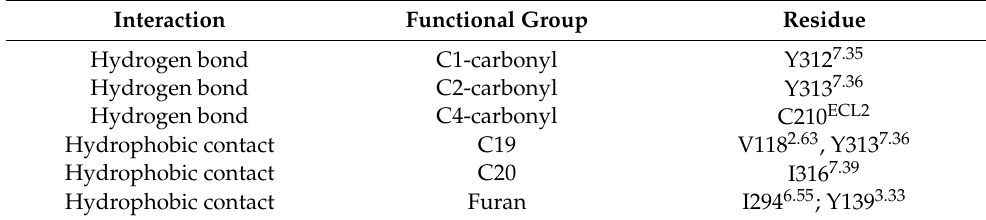
Figure 2. Binding mode of SalA at the KOR. ( A ) shows the overall architecture of KOR bound to SalA while ( B ) highlights the binding pocket of SalA at the KOR. ( C ) depicts the protein-ligand interactions between SalA and KOR. Y 3.33 denotes to Y139 3.33 , C ECL2 to C210 ECL2 , and I 6.55 to I294 6.55 . TM denotes to transmembrane helices, HBA to hydrogen bond acceptor, and HY to hydrophobic contact. Table 1. Protein-ligand interactions between SalA and the